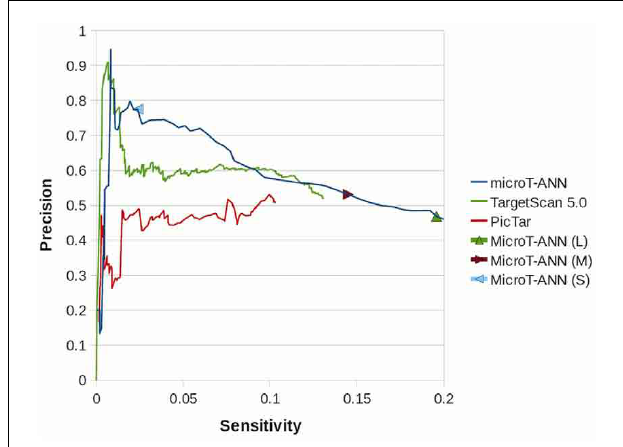
FIGURE 5 | Sensitivity – precision plot for DIANA-microT-ANN, PicTar, andTargetScan 5.0 predictions on the HITS-CLIP dataset of Chi et al. (2009). By lowering the score cutoff, the precision of each algorithm (the fraction of the supported targets correctly predicted, averaged over all miRNAs) is shown versus the sensitivity for that cutoff.The performance of DIANA-microT-ANN at the strict, medium, and loose score cutoffs are also indicated.